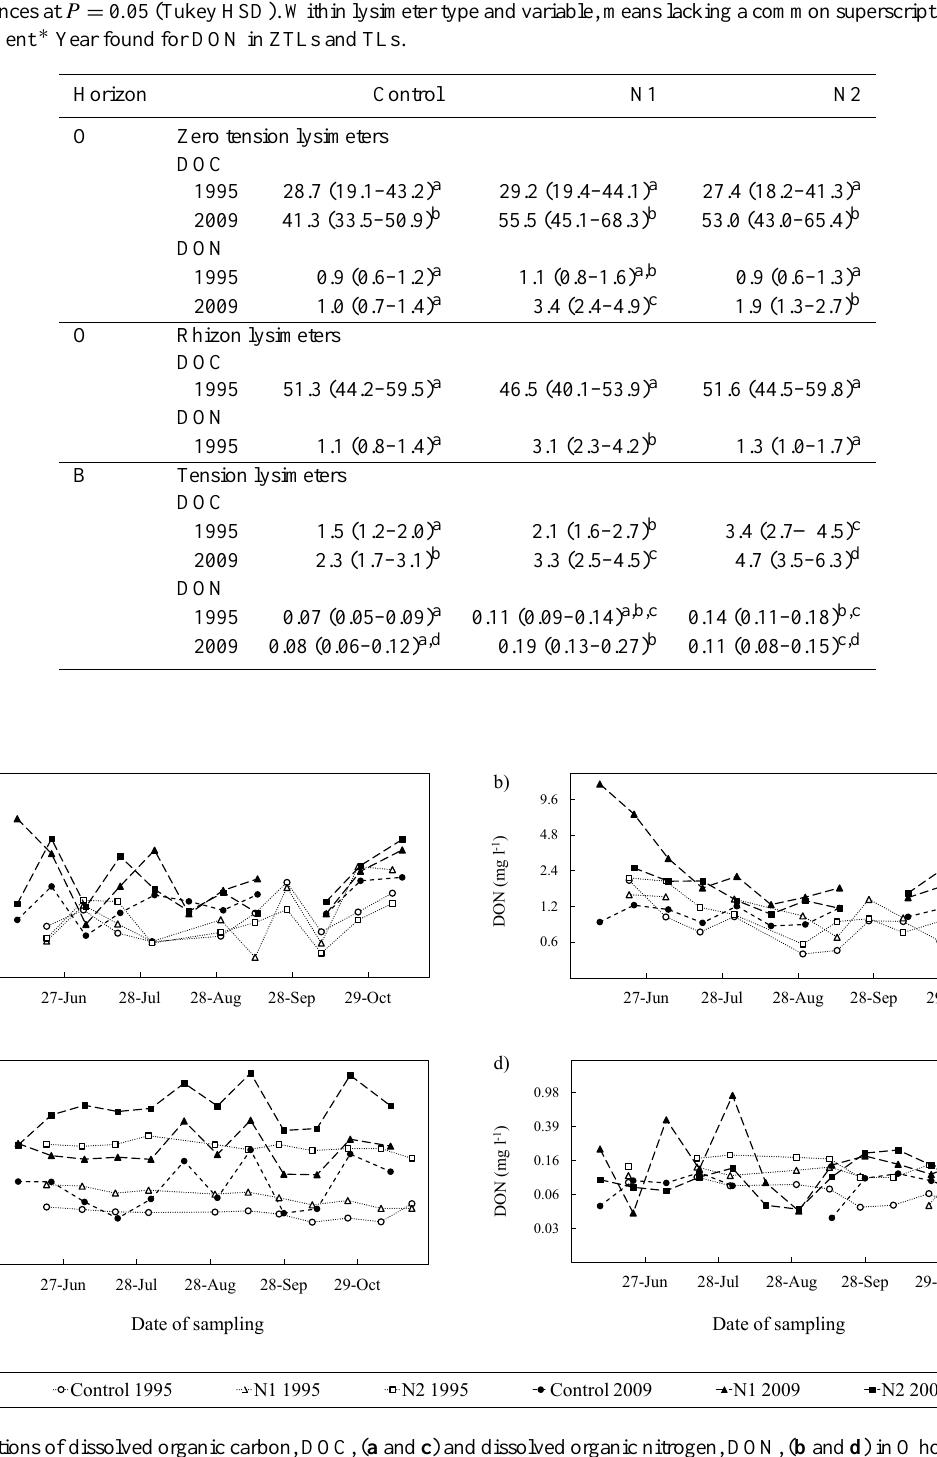
Fig. 1. Concentrations of dissolved organic carbon, DOC, ( a and c ) and dissolved organic nitrogen, DON, ( b and d ) in O horizon ZTL ( a and b ) and mineral B horizon TL ( c and d ) leachates during the growing season of 1995 and 2009. Both DOC and DON are in mgL − 1 . Note that the scales on the y-axis are logarithmic in both (b) and (d)